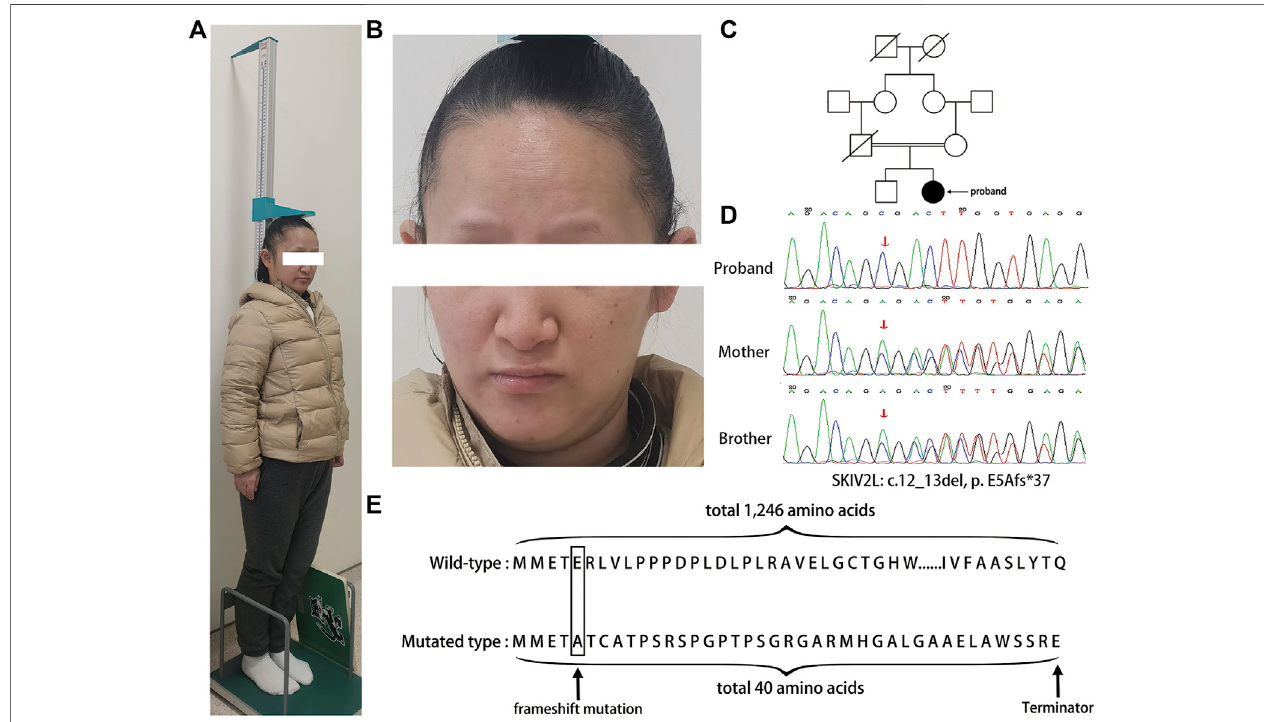
FIGURE 1 | (A) The image shows that the proband was short in stature. (B) The graph shows that the patient had facial dysmorphism. (C) Pedigrees of the family diagnosedwithtrichohepatoentericsyndrome. (D) SangersequencingchromatogramsofDNAsamplesfromtheprobandandhermotherandyoungerbrothershowing the autosomalrecessive mutation, c12_13del in SKIV2L . Arrows indicate thepositionofthe mutation. (E) Amino acidsequences ofwild-type and mutated SKIV2L . The mutation of SKIV2L results in a truncated protein composed of 40 amino acids, compared with the wild-type SKIV2L , which is composed of 1246 amino acids.